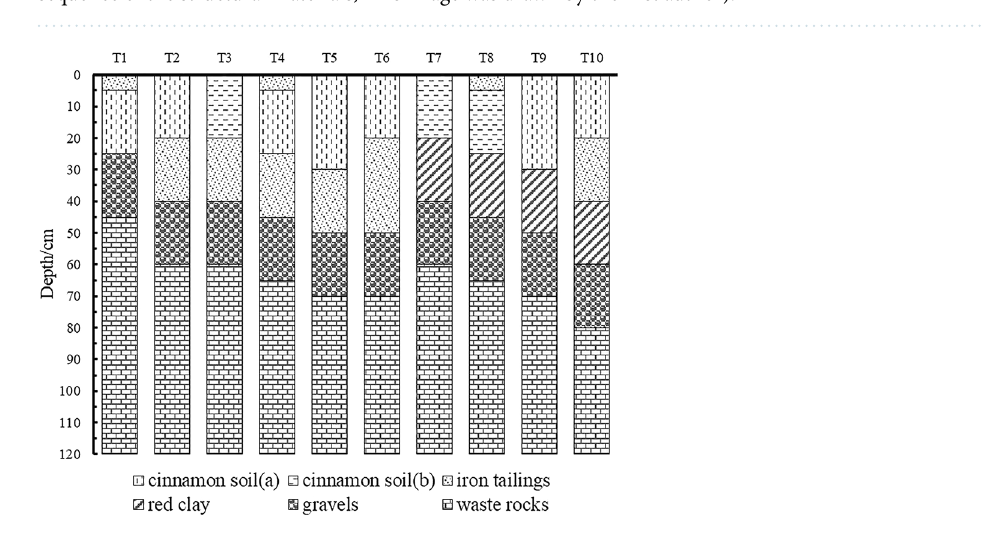
Figure 2. Photos of the farmland construction procedure (Note: ① , ② , ③ , and ④ indicate the placement sequence of the structural materials; This image was drawn by the first author).